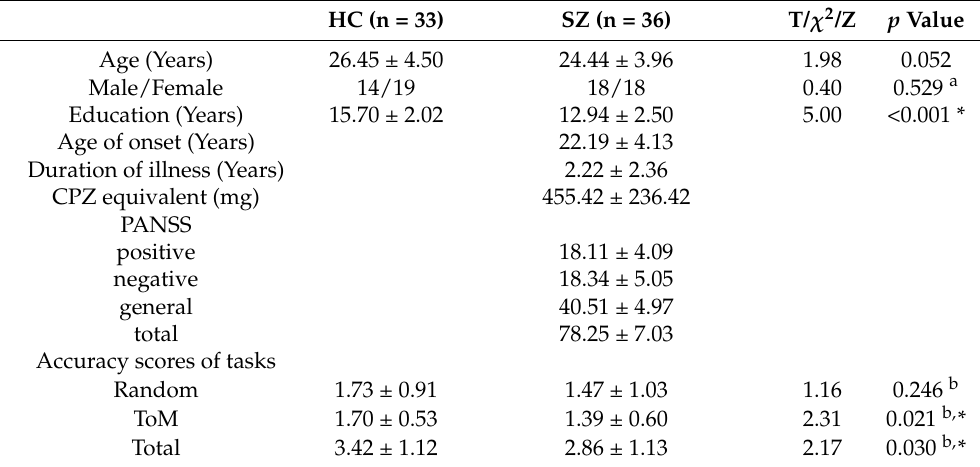
Table 1. Demographic, clinical, and behavioral characteristics of all participants.